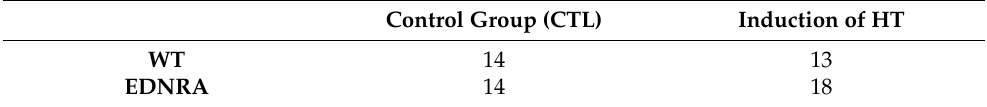
Table 1. Distribution of rats in four experimental